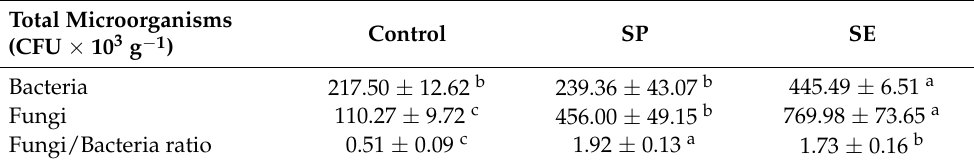
Table 5. Total number of microorganisms (colony forming units (CFU) g − 1 in substrate dry weight (DW)) determined in substrates after a 45-day